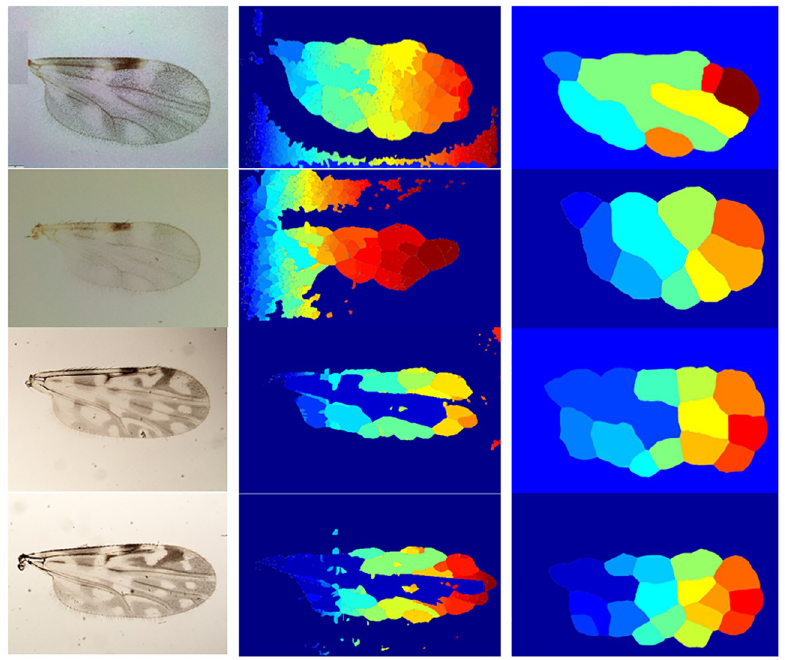
Fig 12. Resulting segmented zones obtained by the watershed method on C.obsoletus (first row), C.pusillus (second row), C.foxi (third row), and C.insignis (fourth row) samples. Left: original wing image. Center: results obtained after applying the method proposed by Benalca´zar et al. [24]. Right: results obtained after applying the method proposed in this paper.